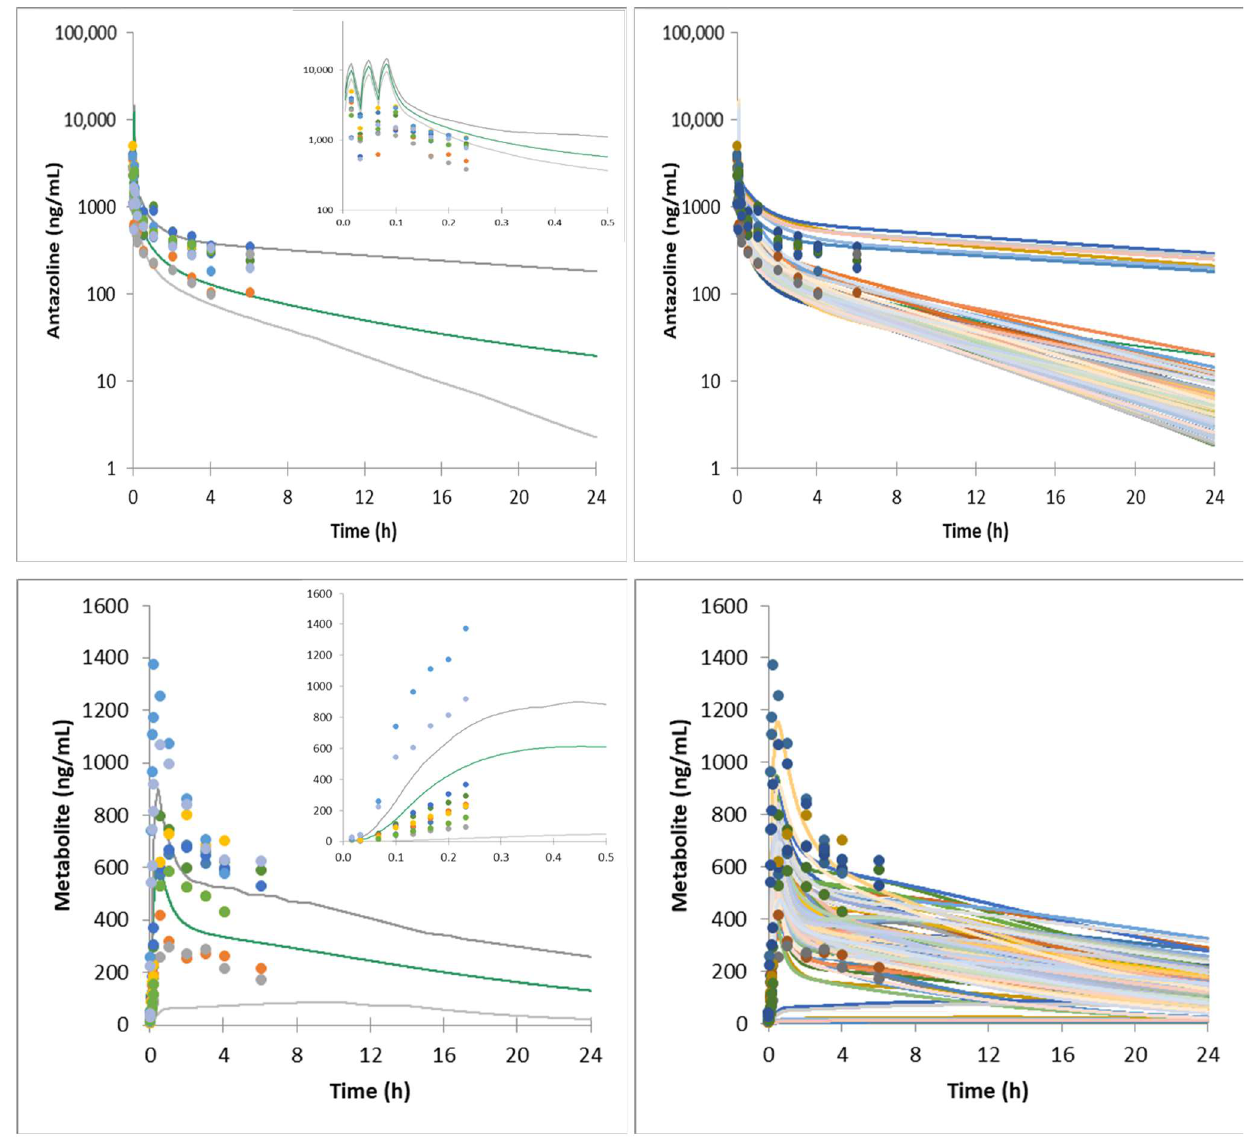
Figure 2. Mean and individual simulated systemic plasma concentration profiles of antazoline and its metabolite following 300 mg antazoline infusion (healthy volunteers, ELEPHANT II study). Dots—observed individual data; gray lines—5th and 95th percentile; green line—simulated average concentration; colour lines—simulated individual concentrations.